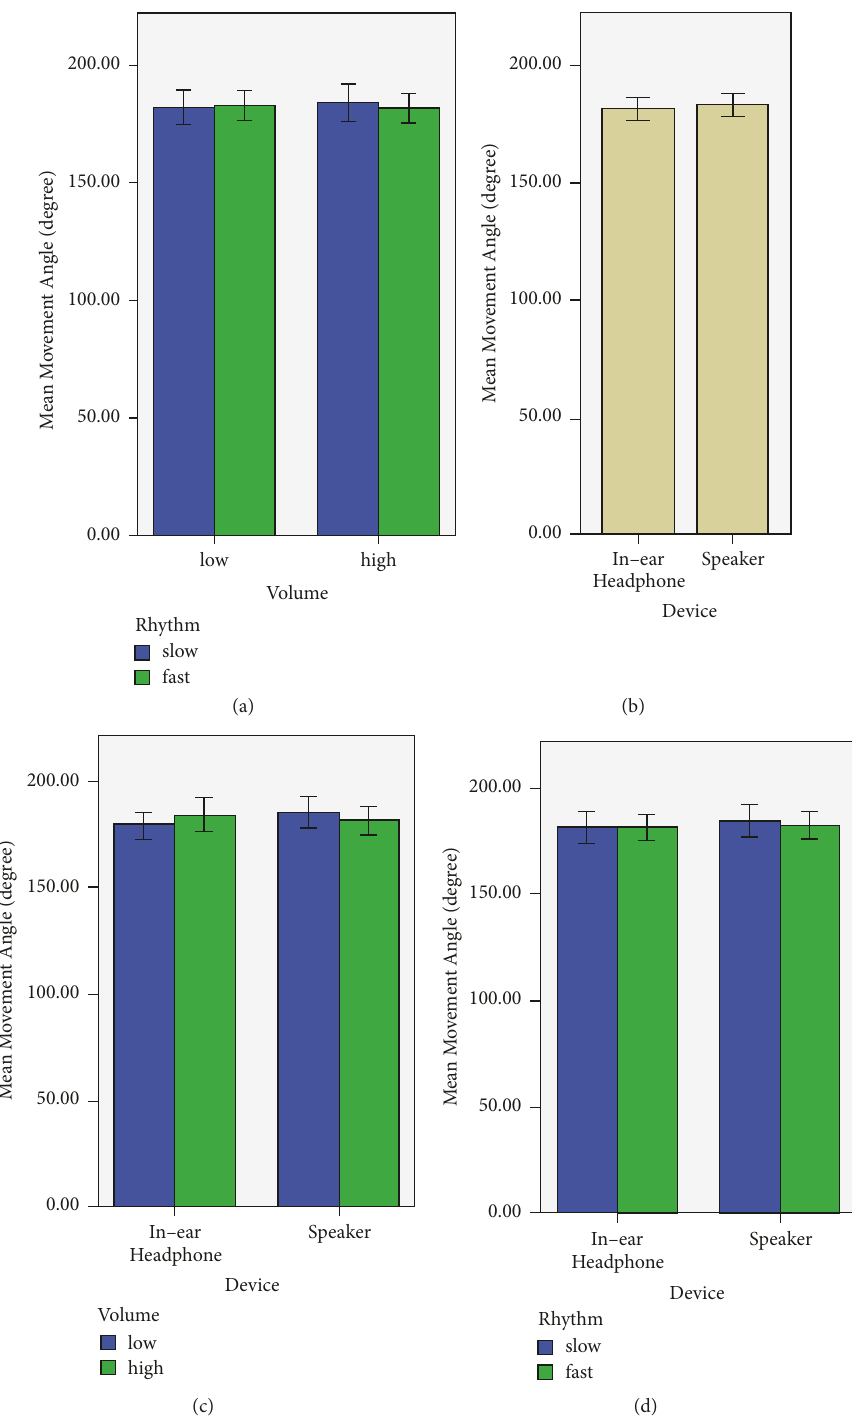
Figure 12: Mean head movement angle for (a) Volume × Rhythm; (B) Device; (C) Device × Volume; (D) Device ×